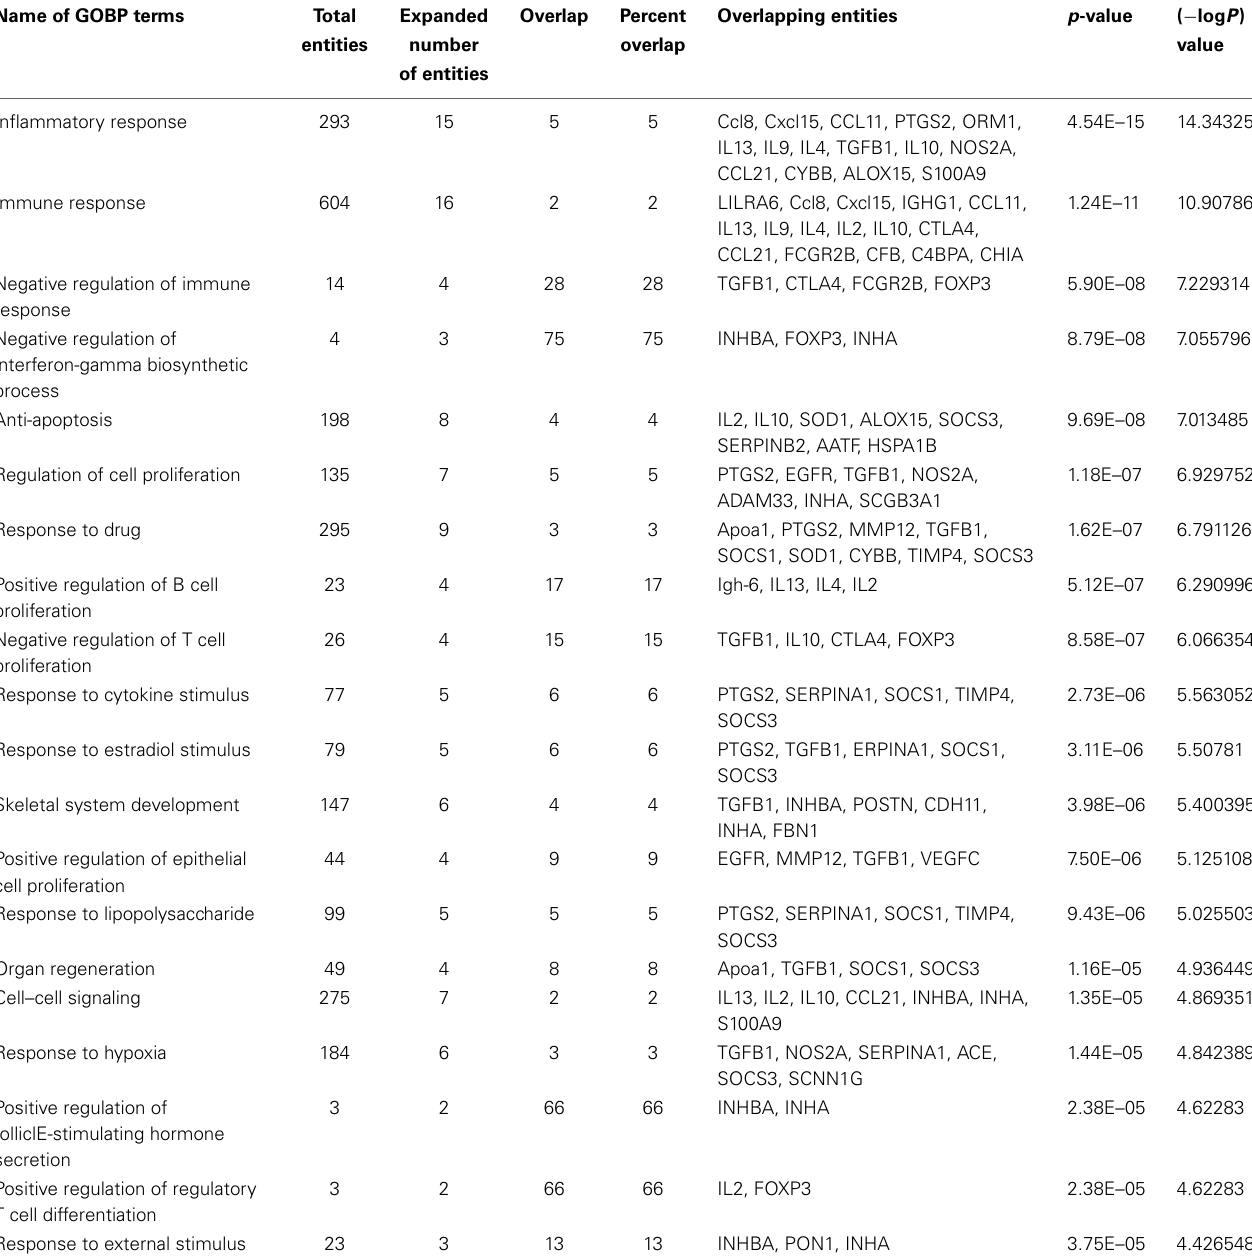
Table A3 | The list of Gene Ontology Biological Process (GOBP) terms that are significant in asthma pathogenesis, as evident from the biomarkers identified by genomics, proteomics and epigenomics